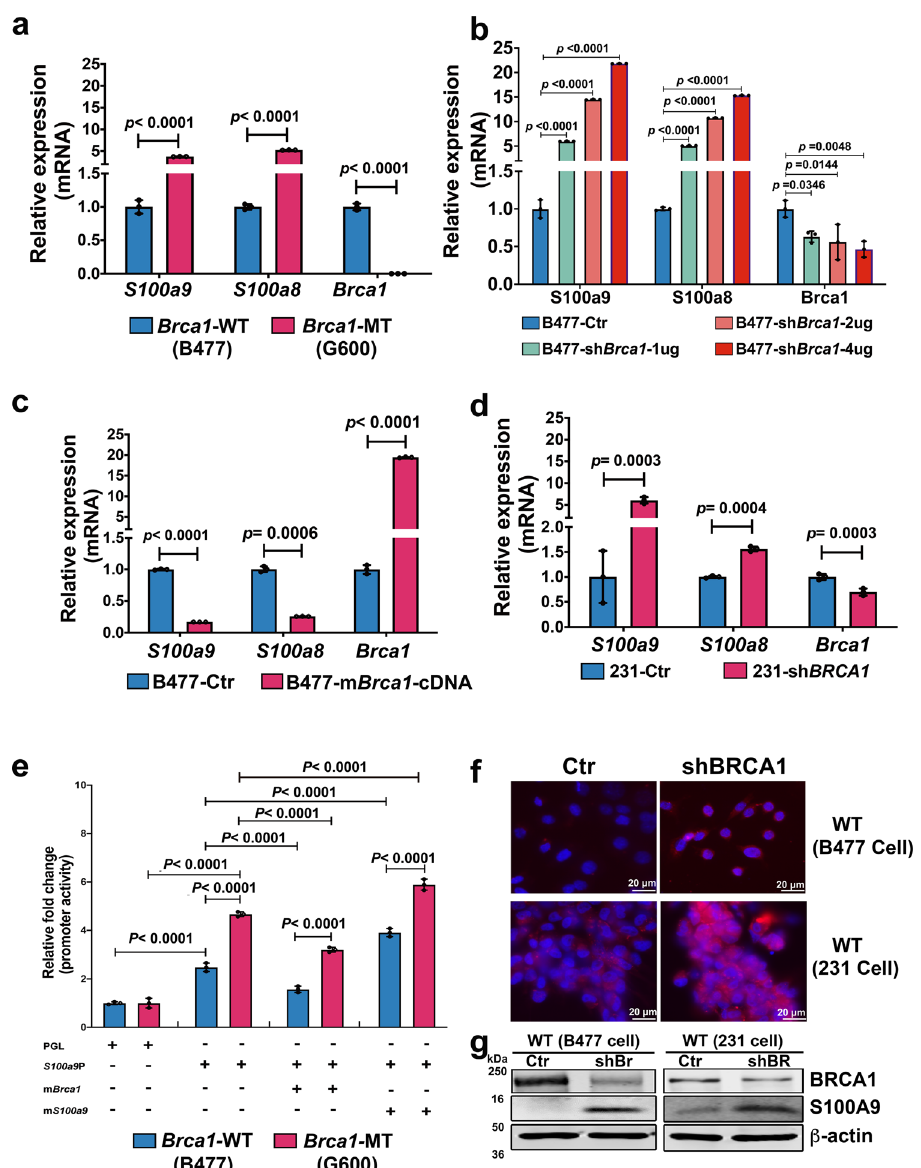
Fig. 3 S100a9 gene is regulated by both Brca1 and S100a9. a Expression of S100a9 and S100a8 in Brca1 MT (G600) and WT (B477) mammary epithelial cell lines. b Expression of S100a9 and S100a8 in B477 cells with the expression of sh Brca1 at different concentrations. c Expression of S100a9 and S100a8 in B477 cells in which the mBrca1 gene was overexpressed. d Expression of S100A9 and S100A8 in MDA-MB-231 (231) control and 231 cells with